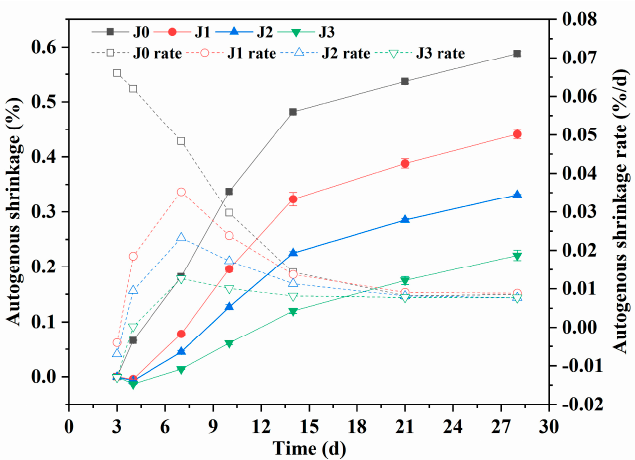
Figure 5. Autogenous shrinkage and shrinkage rate of M-S-H mortar with SRA.